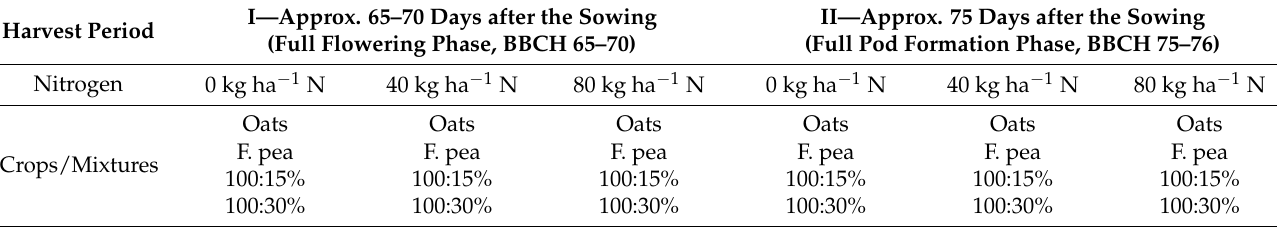
Table 2. Tested factors and their